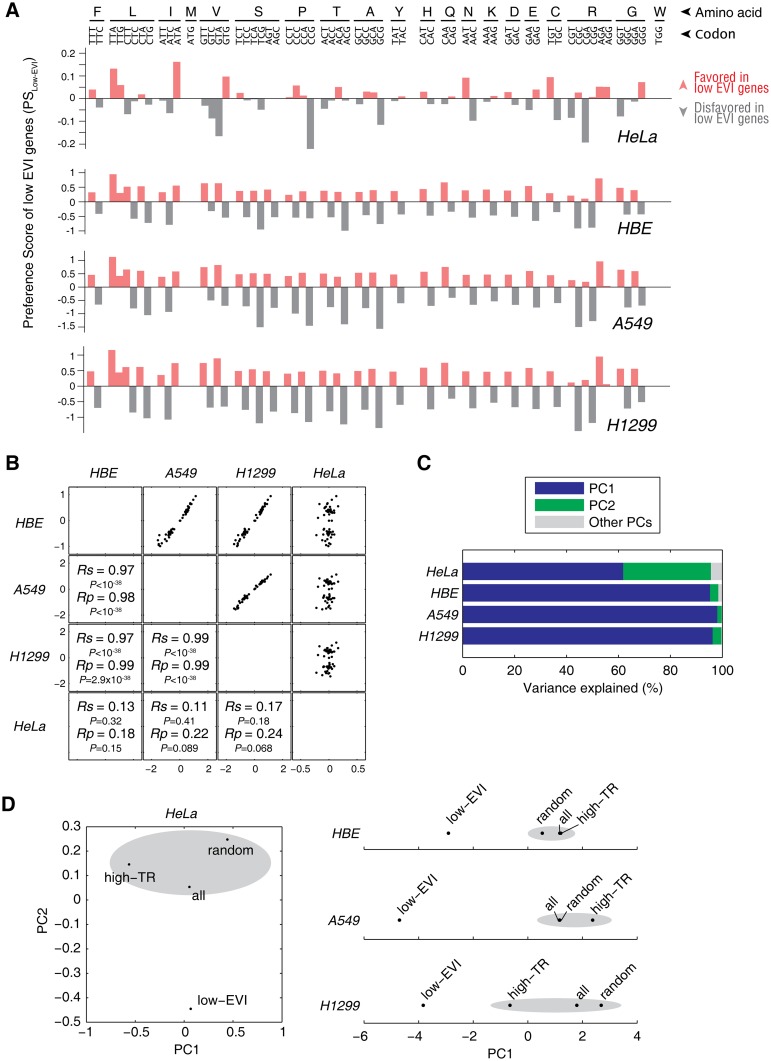
Codon preference of the slow-translating genes.(A) Codon preference of low EVI genes in the four cell lines based on Preference Score analysis. For details, please refer to Materials and Methods section. Favored and disfavored codons are shown in red and grey bars, respectively. (B) Mutual correlation of PSLow-EVI of codons among all four analyzed cell lines. (C) Percentage of variance explained in the principle component analysis (PCA) on RSCU. (D) Principle component (PC) based clustering analysis. The PCs with the summed explained variance greater than 80% were taken for clustering analyses based on the standardized Euclidean distances. For each cell line, four groups of genes were analyzed. They were low EVI genes, high TR genes, all genes and a random subset of genes that were inside the 95% confidence ellipse (Fig 2A and 2B). The clusters with multiple gene groups are indicated by grey ellipses.